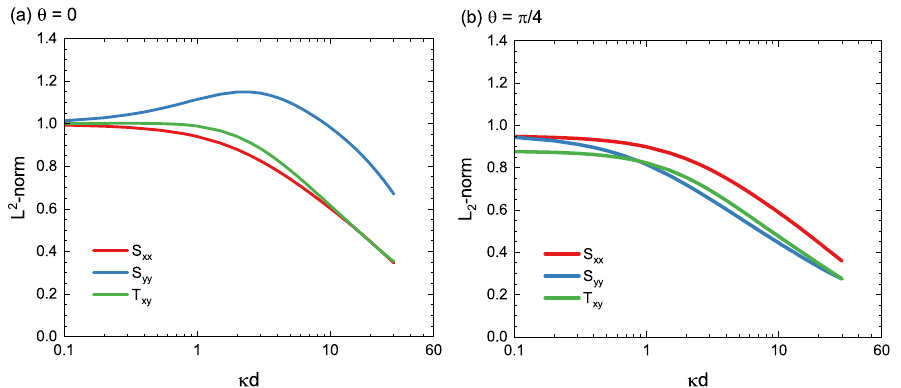
Figure 7. L 2 -norm of the stress distribution from those produced by the real edge dislocation; see Equation (47) for the definitions of the L 2 -norm. ( a ) θ = 0, ( b ) θ = π